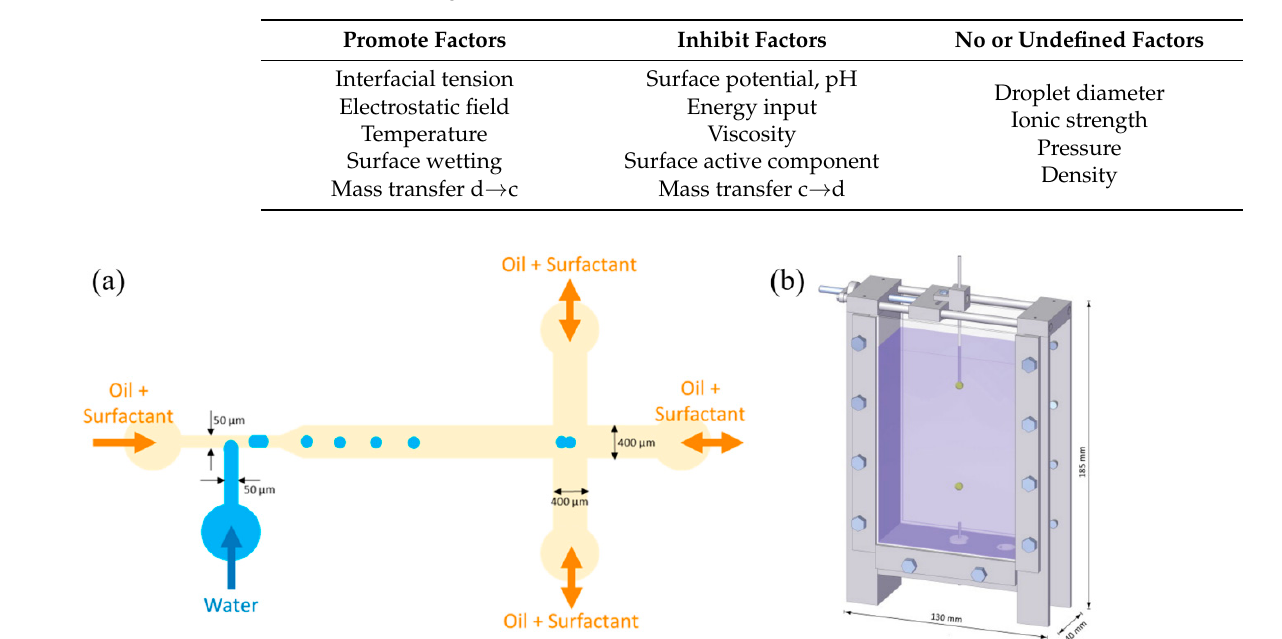
Table 6. Influencing factors on coalescence [81].